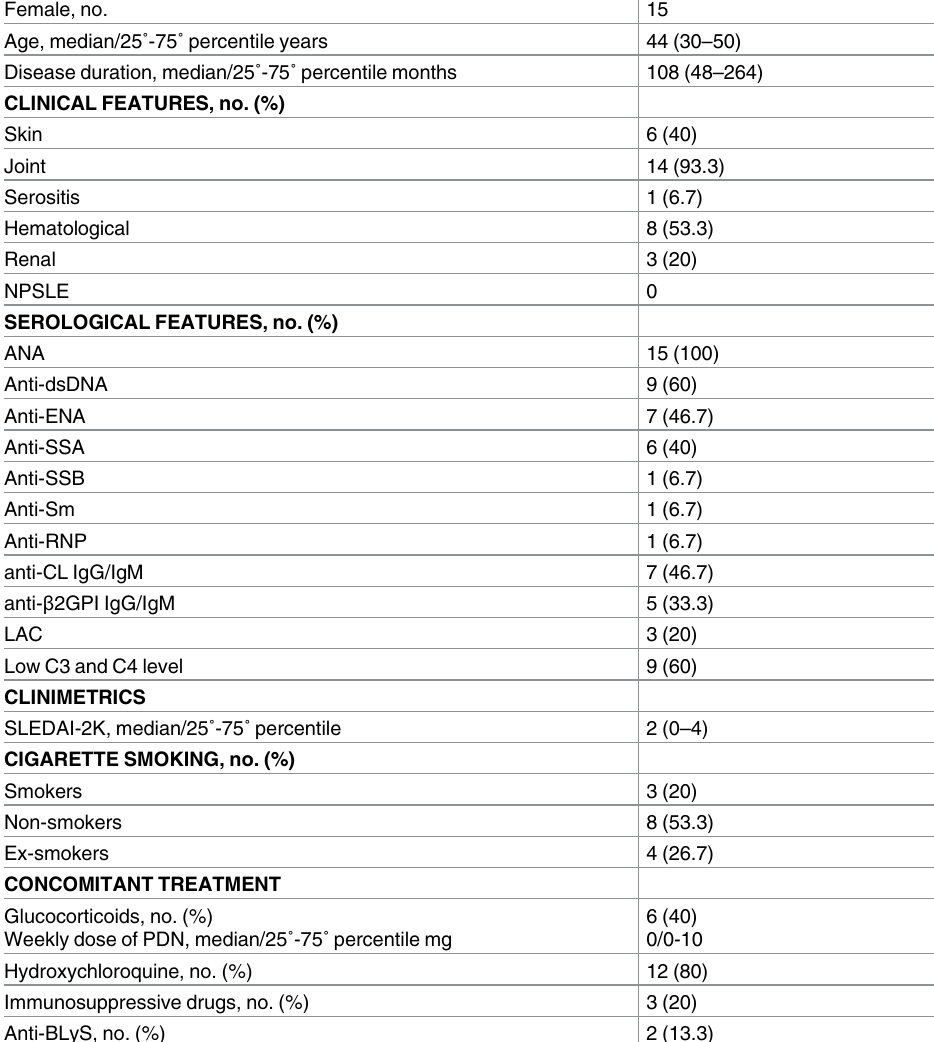
Table 2. Demographic, clinical, serological and therapeutic featuresof patients with systemiclupus erythematosus (n = 15). Female, no. 15 Age, median/25˚-75˚ percentile years 44